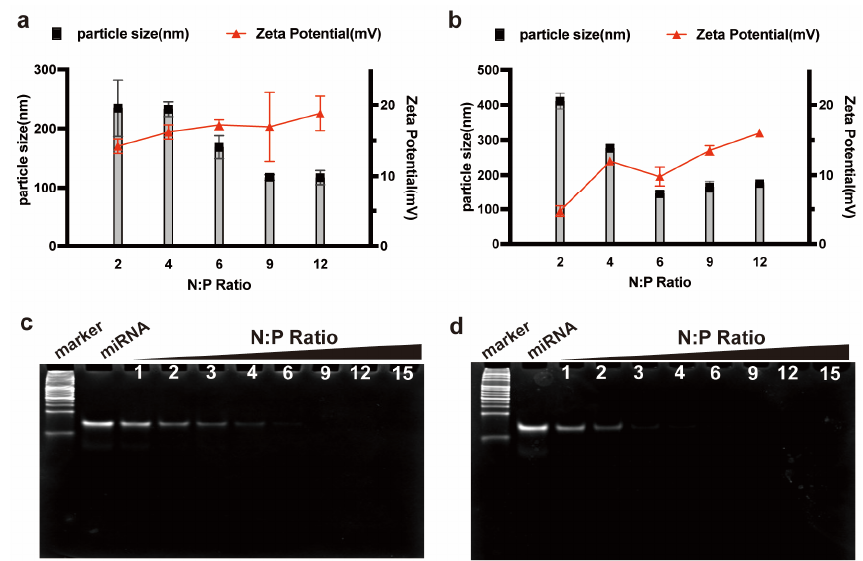
Figure 4. Characterization of RALA-E/miR146a complexes. Particle size and Zeta potential of RALA/miR146a complexes ( a ) and RALA-E/miR146a complexes ( b ). Page gel retardation assay of RALA/miR146a complexes ( c ) and RALA-E/miR146a complexes ( d ). The numbers (2, 4, 6, 9, 12, or 1, 2, 3, 4, 6, 9, 12, 15) in this Figure denote N:P ratios.